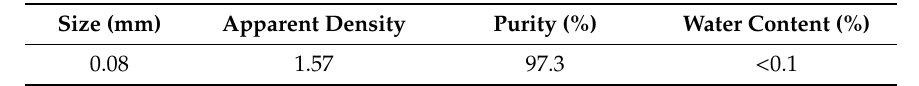
Table 2. Properties of silica sand.